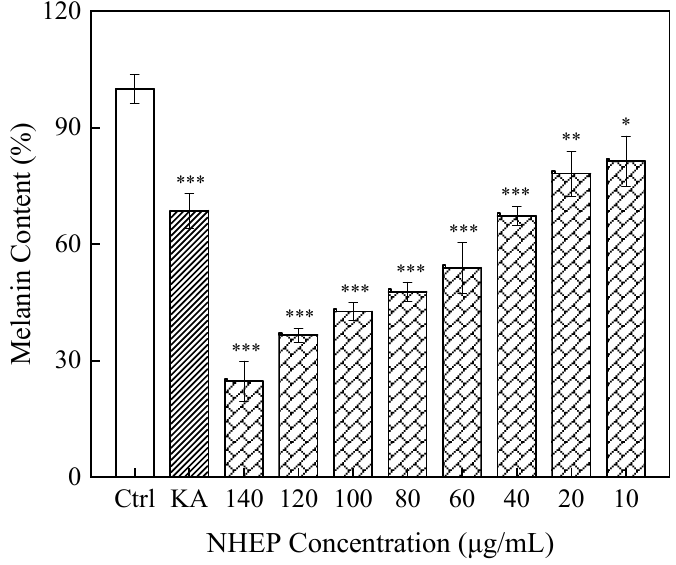
Figure 12. Effects of the NHEP on B16 cells melanin production. Significance: compared with the control group, * p < 0.05, ** p < 0.01, *** p < 0.001. The data shows as the mean ± S.D. ( n = 5). KA stands for Kojic acid, and the concentration is 20 μ g/mL.